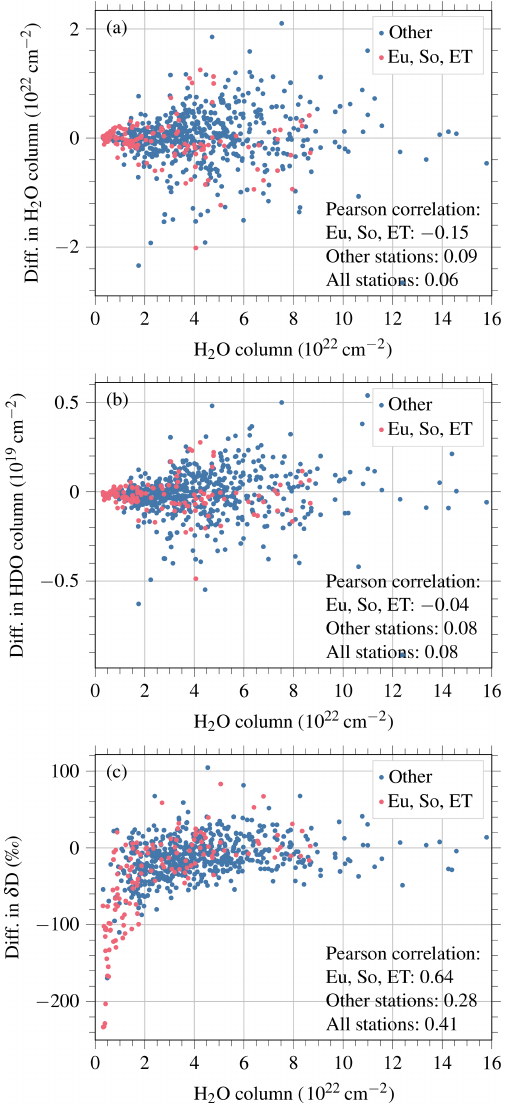
Figure 9. Dependence of the difference (TROPOMI – TCCON) of H 2 O (a) , HDO (b) and a posteriori δ D (c) on the TROPOMI H 2 O column. Data from the high-latitude stations Eureka (Eu), So- dankylä (So) and East Trout Lake (ET) are marked using red, and those from the other stations are marked using